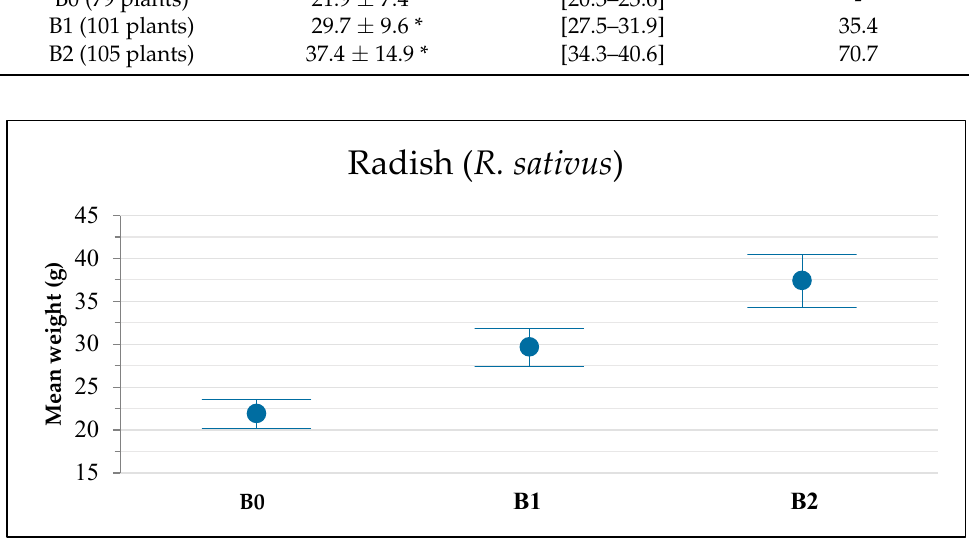
Figure 3. Mean radish weight and confidence interval of each treatment ( α = 0.05).